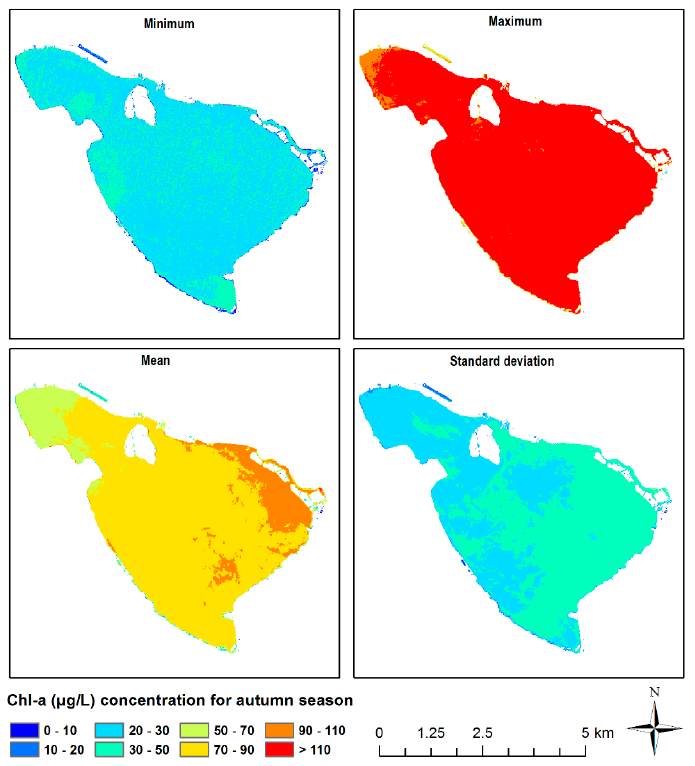
Figure A8. Chl- a concentration for an autumn season.